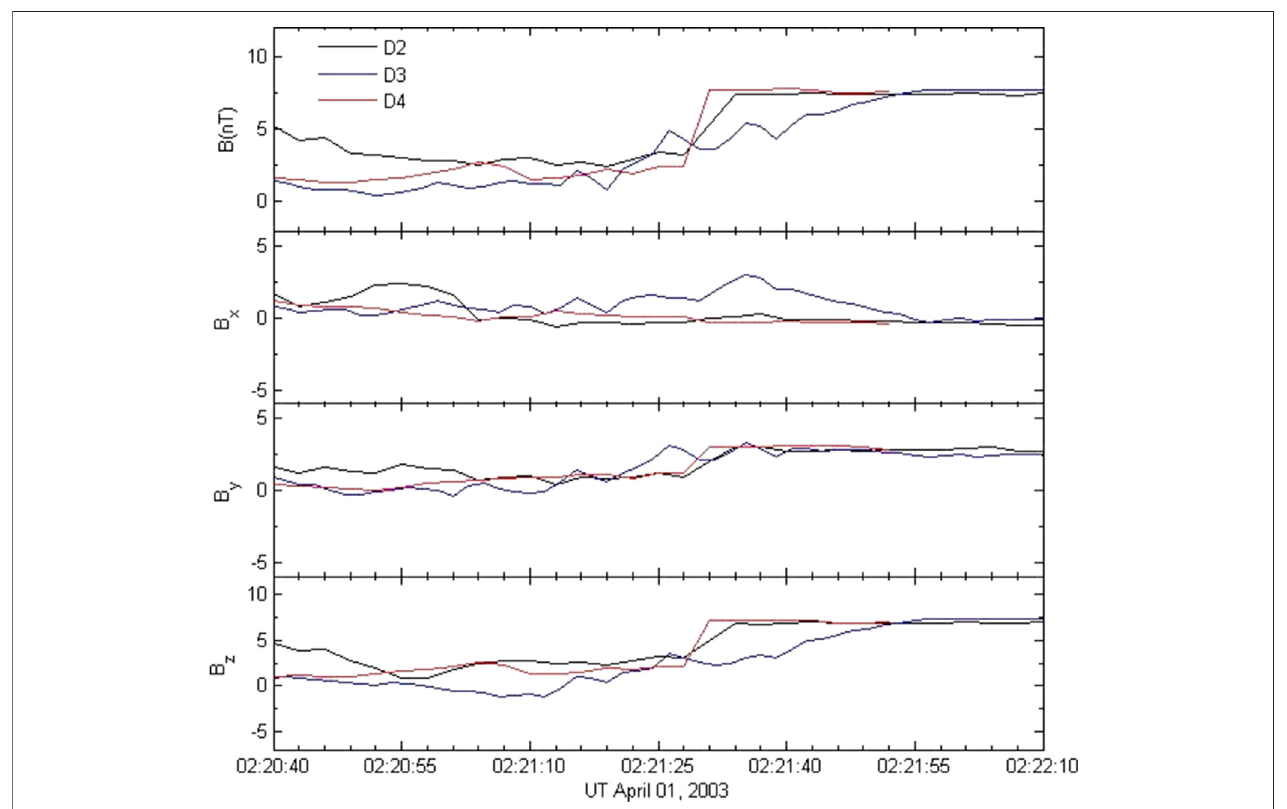
FIGURE4| Magnetic fi elddataaroundthedirectionaldiscontinuitiesD2,D3,andD4;D3andD4wereshiftedforwardintimeby135and378 s,andthetimeseries of D3 are reversed.